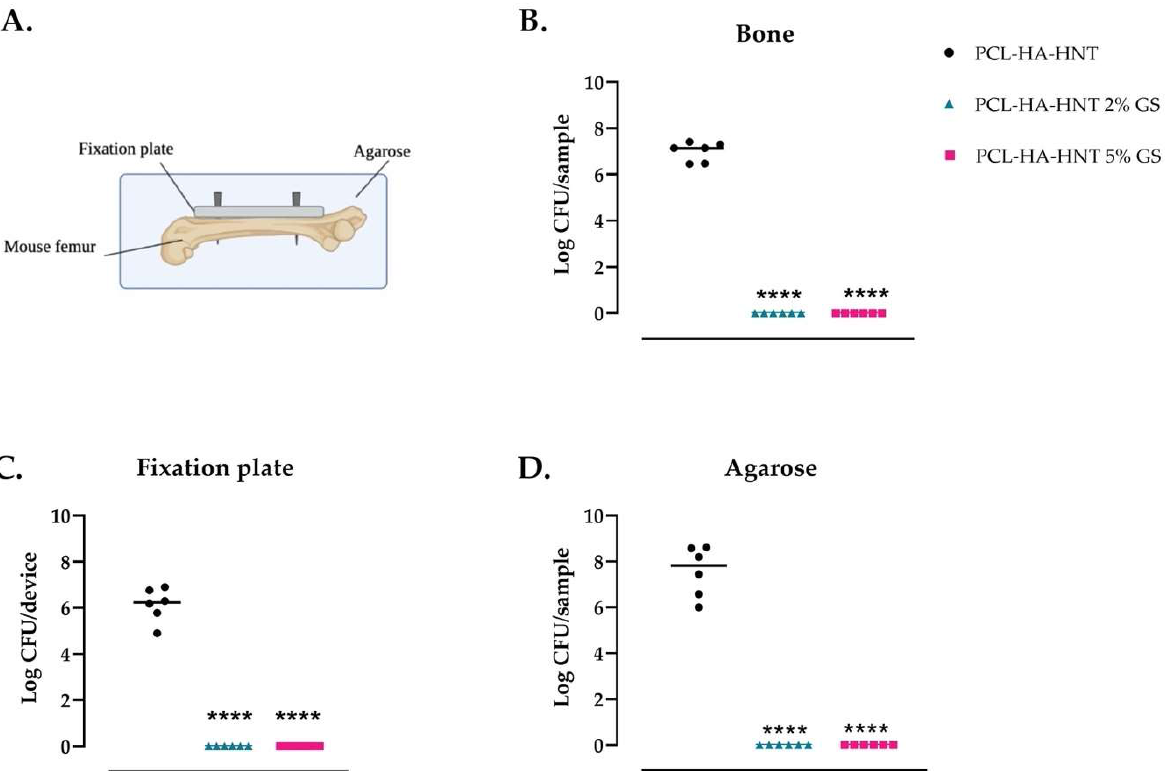
Figure 9. Antimicrobial activity of the fixation plates against S. aureus JAR 06.01.31 in an ex vivo mouse femur fixation plate infection model. PCL-HA-HNT plates, either non-loaded or loaded with 2 or 5% GS, were fixed to the femurs with 2 titanium pins and then inoculated with 1 µ L containing 10 4 CFU through a drilled hole in the center of the femur of (Ø 0.5 mm) Then, the inoculated femur with the fixed plate was placed in a container and covered with low melting agarose to mimic the surrounding tissue and incubated for 24 h. Schematic representation of the ex vivo model ( A ) and the quantification of bacterial colonies of S. aureus retrieved from the bones ( B ), the biomaterial ( C ) and agarose ( D ). Note: n = 6 per group. **** Indicates a p -value < 0.0001 versus the non-loaded plates.